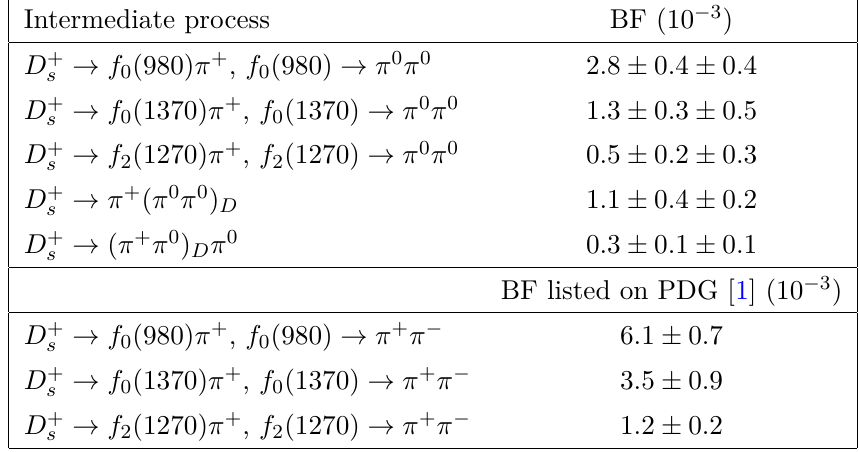
Table 9 . The BFs for intermediate processes. and the BFs listed on PDG. The first and the second uncertainties are statistical and systematic, respectively. to the large dataset collected with the BESIII detector. The BFs for the intermediate processes are calculated with B = FF × B ( D + → π + π 0 π 0 ) and listed in table 9. The i i s BF of D + → f (980) π + with f (980) → π 0 π 0 is measured for the first time. In addition, 0 0 s no significant signal of f (500) is 0